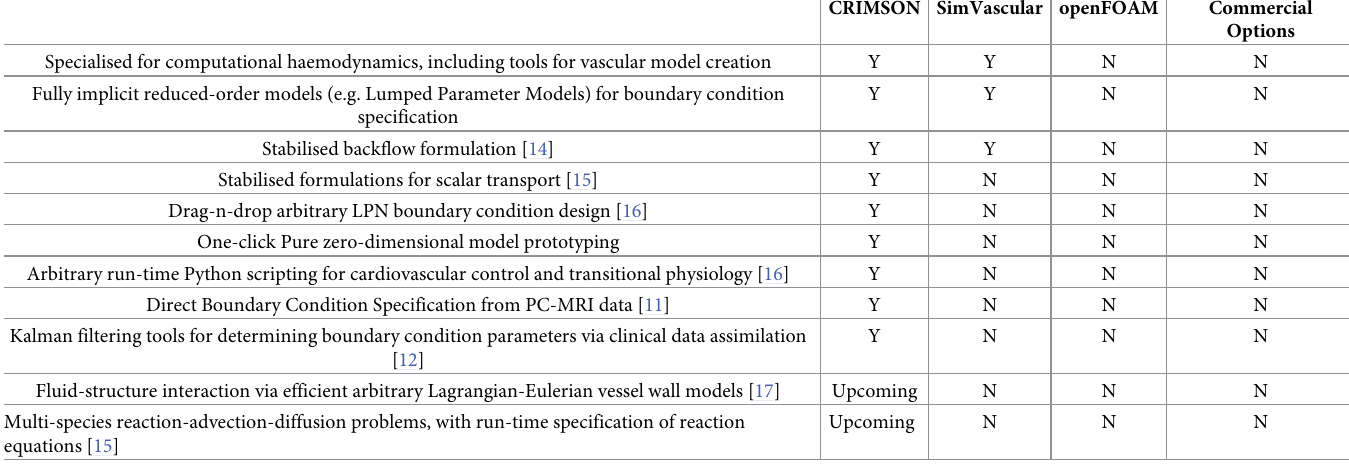
Table 1. Comparison of selected key features for computational haemodynamics, between CRIMSON and other packages. The information in the table is to the best of our knowledge at the time of writing. Readers are advised to make their own comparisons.